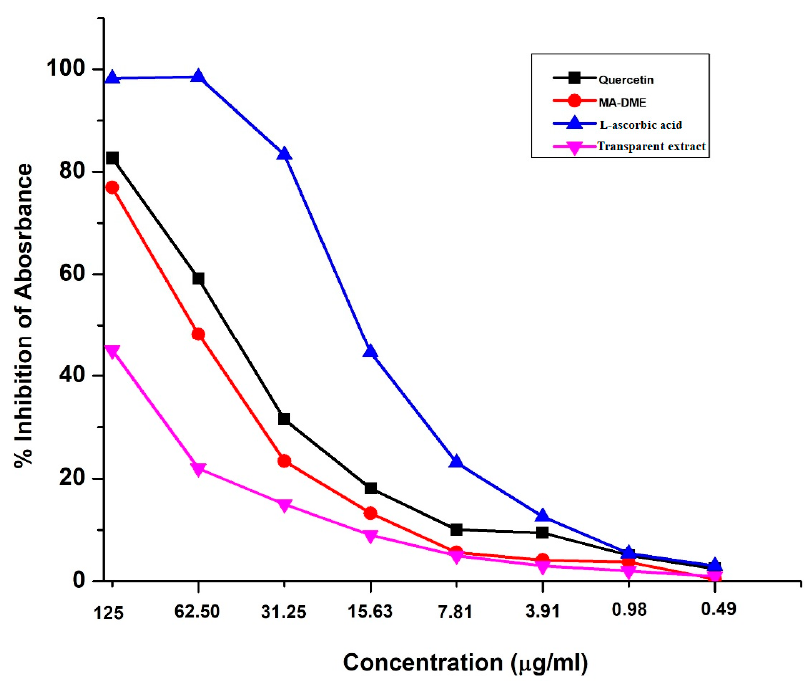
Figure 5. ABTS radical scavenging activity of MA-DME and Transparent